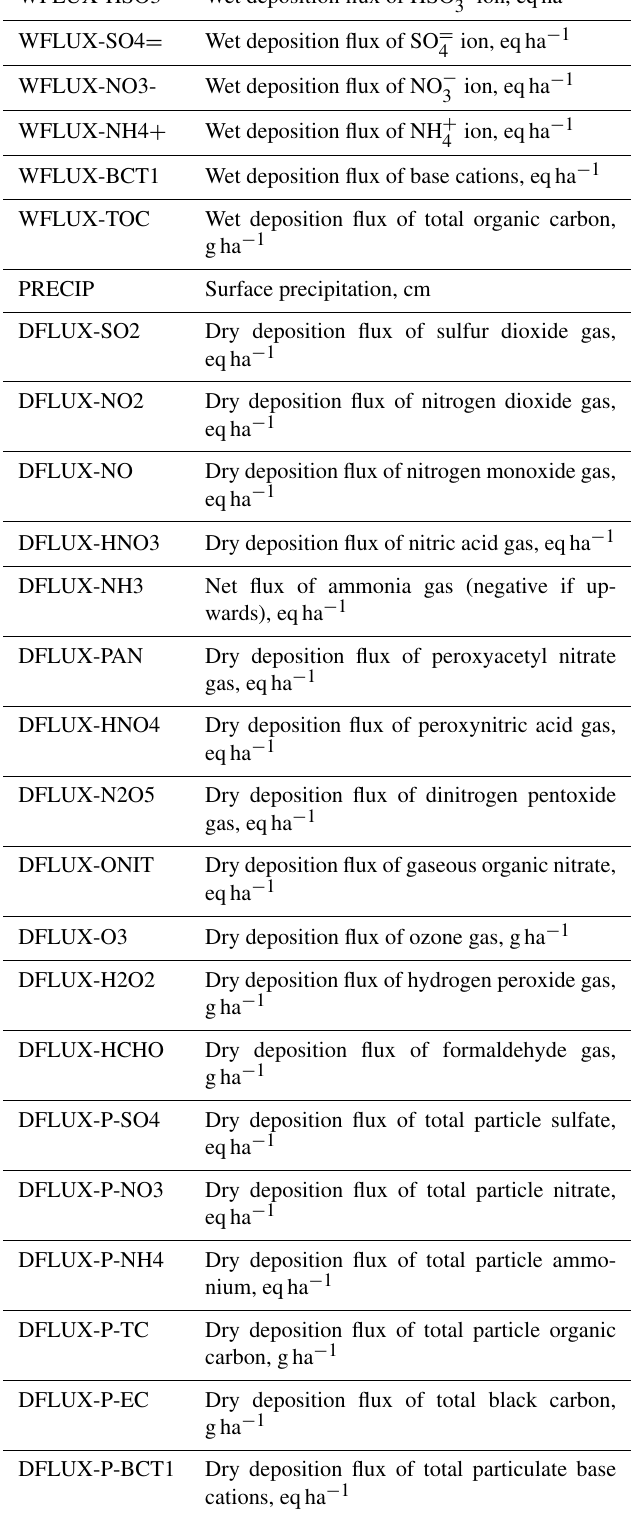
Table A3. AQMEII4 – deposition fluxes